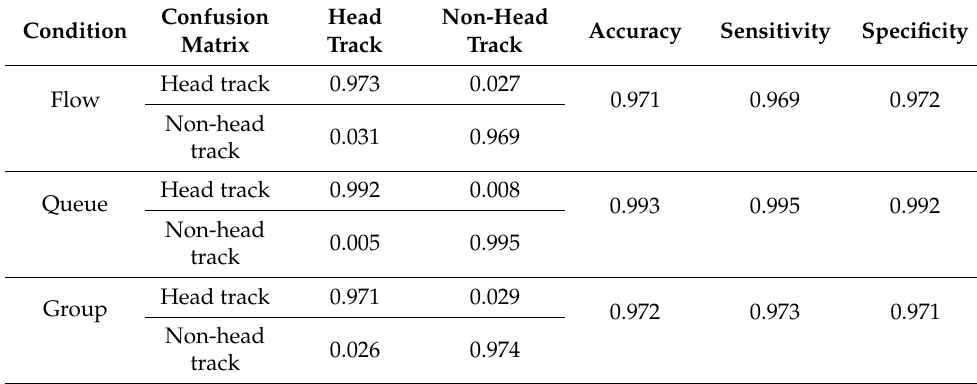
Table 4. Tracking Accuracy achieved over the MICC People Counting dataset.